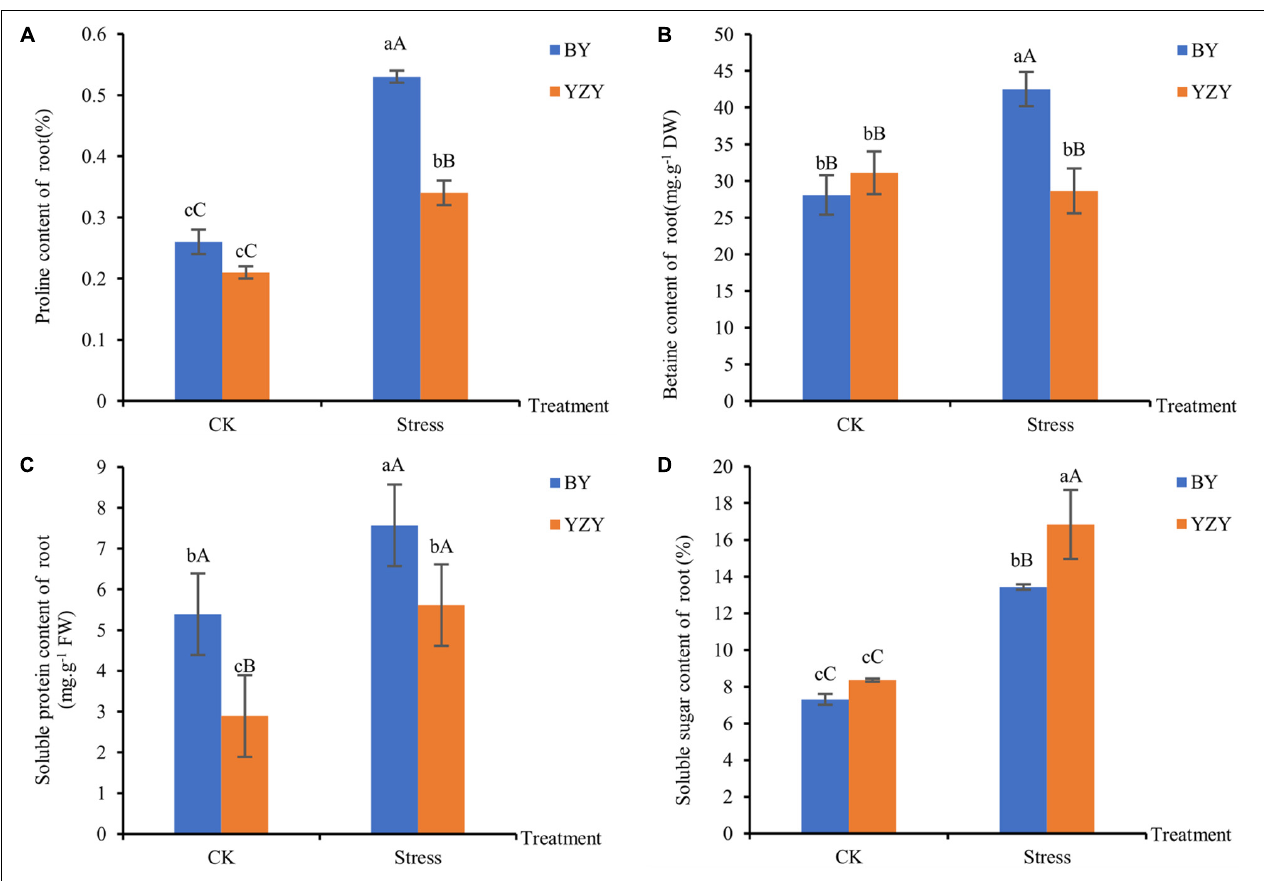
FIGURE 4 | Osmoregulation substances of oat seedling roots under CK and saline-alkali stress conditions. (A) Proline content of BY and YZY roots under saline-alkali stress treatment and CK conditions. (B) Betaine content, (C) soluble protein content, and (D) soluble sugar content. FW, fresh weight; DW, dry